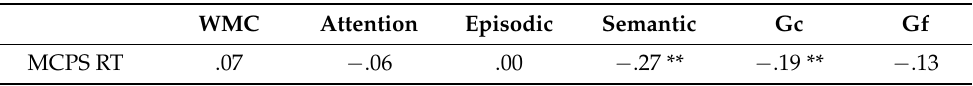
Figure 6. The full structural model of working memory capacity (WMC), attention control (attention), episodic memory (episodic), semantic memory (semantic), crystallized intelligence (Gc), and fluid intelligence (Gf) loading onto median response time for multiply-constrained problems correctly solved. Dashed lines represent nonsignificant paths. Values on paths represent standardized regression coefficients. Table 7. Latent factor correlations between cognitive abilities and median response times for multiply-constrained problems correctly solved (MCPS RT).